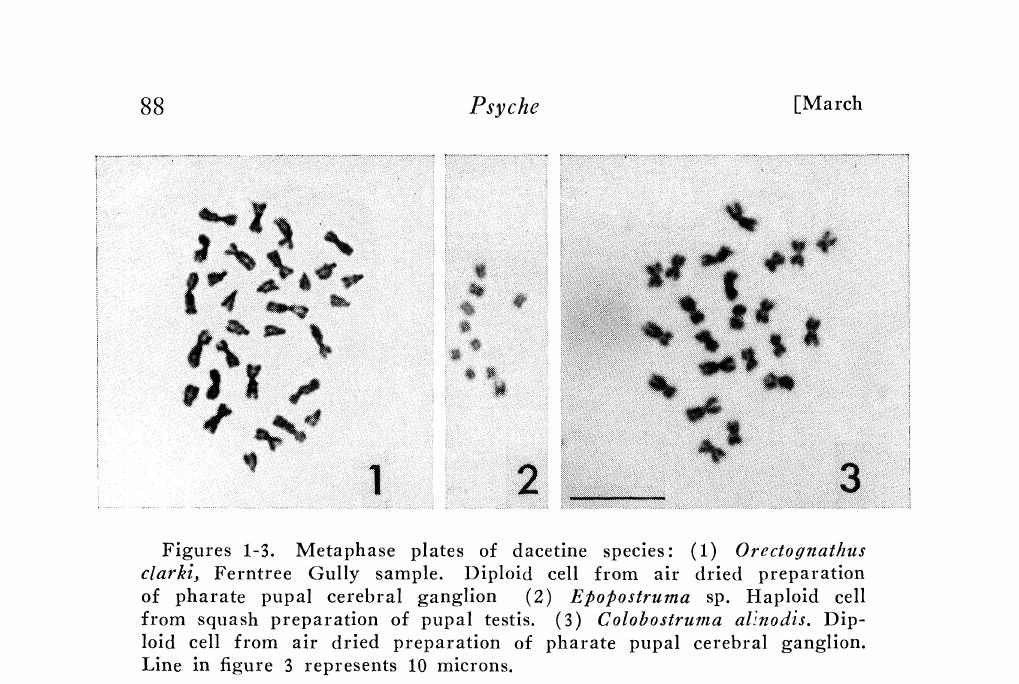
Figures 1-3. Metaphase plates of dacetine species: (1) Orectognathus clarki, Ferntree Gully sample. Diploid cell from air dried preparation of pharate pupal cerebral ganglion (2) Epopostruma sp. ttaploid cell from squash preparation of pupal testis. (3) Colobostruma alinodis. Dip- loid cell from air dried preparation of pharate pupal cerebral ganglion. Line in figure represents 10